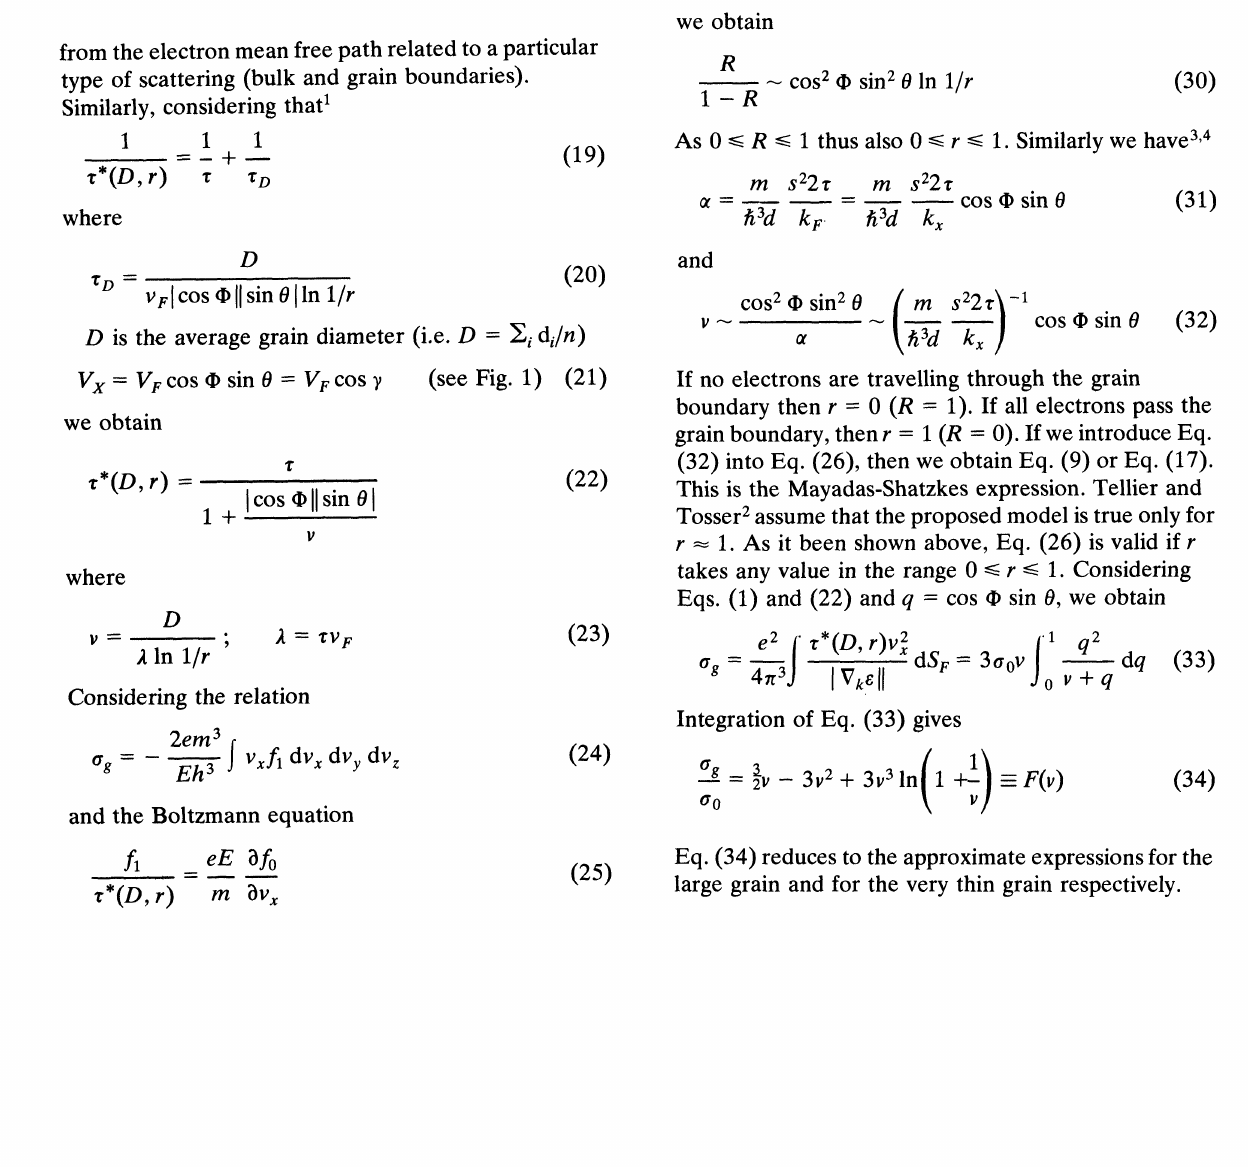
FIGURE Geometry of the scattering planes model from the electron mean free path related to a particular type of scattering (bulk and grain